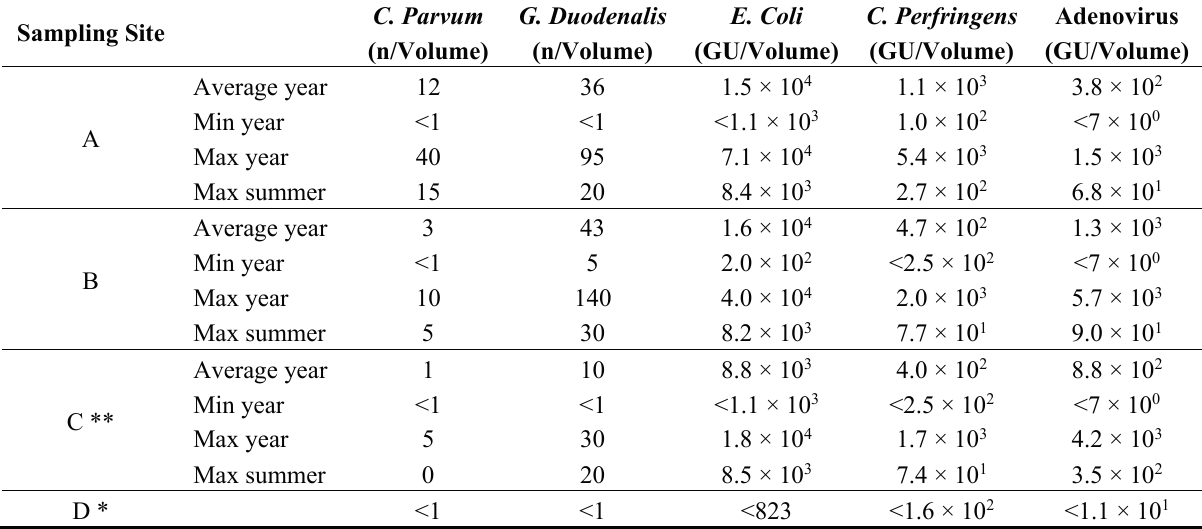
Table 1. Microorganism concentrations for river (50 L filtered) and drinking water samples (1000 L